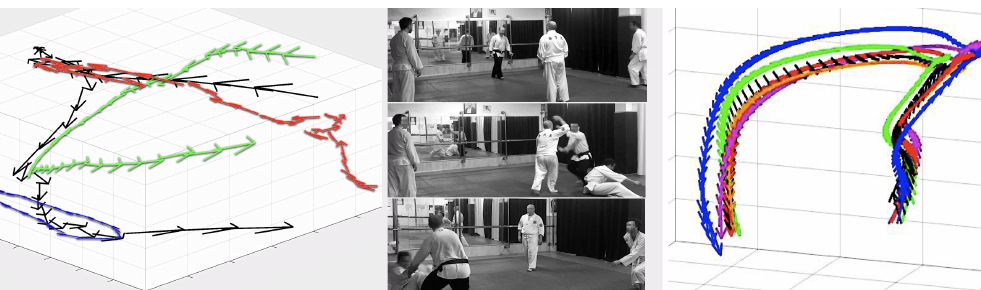
Figure 8. Left and middle images: Dead reckoning application from the measured acceleration streams obtained during a multiple attacker freestyle exercise ( taninzu gake ). The arrow plot on the left shows the trajectories (and speed at each point) of each uke or attacker (blue, green and red colors) and the tori or defender (black color) in the 3D space (shown as photographs on the right). The size of the arrows represents the intensity of the speed of each partner. Photos taken at Judelda dojo (Elda, Spain). Rightmost image: Derived tracks of the dead reckoning between four AX3s running at 3200 (black), 1600 (green), 800 (red) and 100 (blue) Hz, respectively, and two iPhone models: 6S+ (orange track) and 5 (purple track) running both at 100 Hz. The orientation/size of the arrows reflects the velocity vector at each given position. The difference in the mean position (between all devices) is obvious, but not significant for the learning scenarios described in this text. In the case of the speed, the mean difference is just a few cm/s (also negligible for the academic purposes regarding the learning of